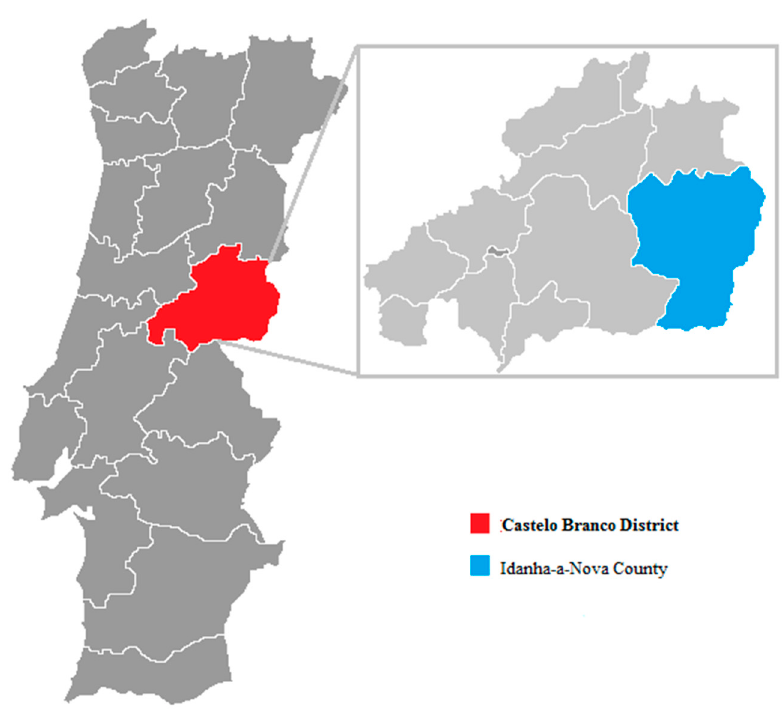
Figure 1. Idanha-a-Nova County in a map of Portugal.